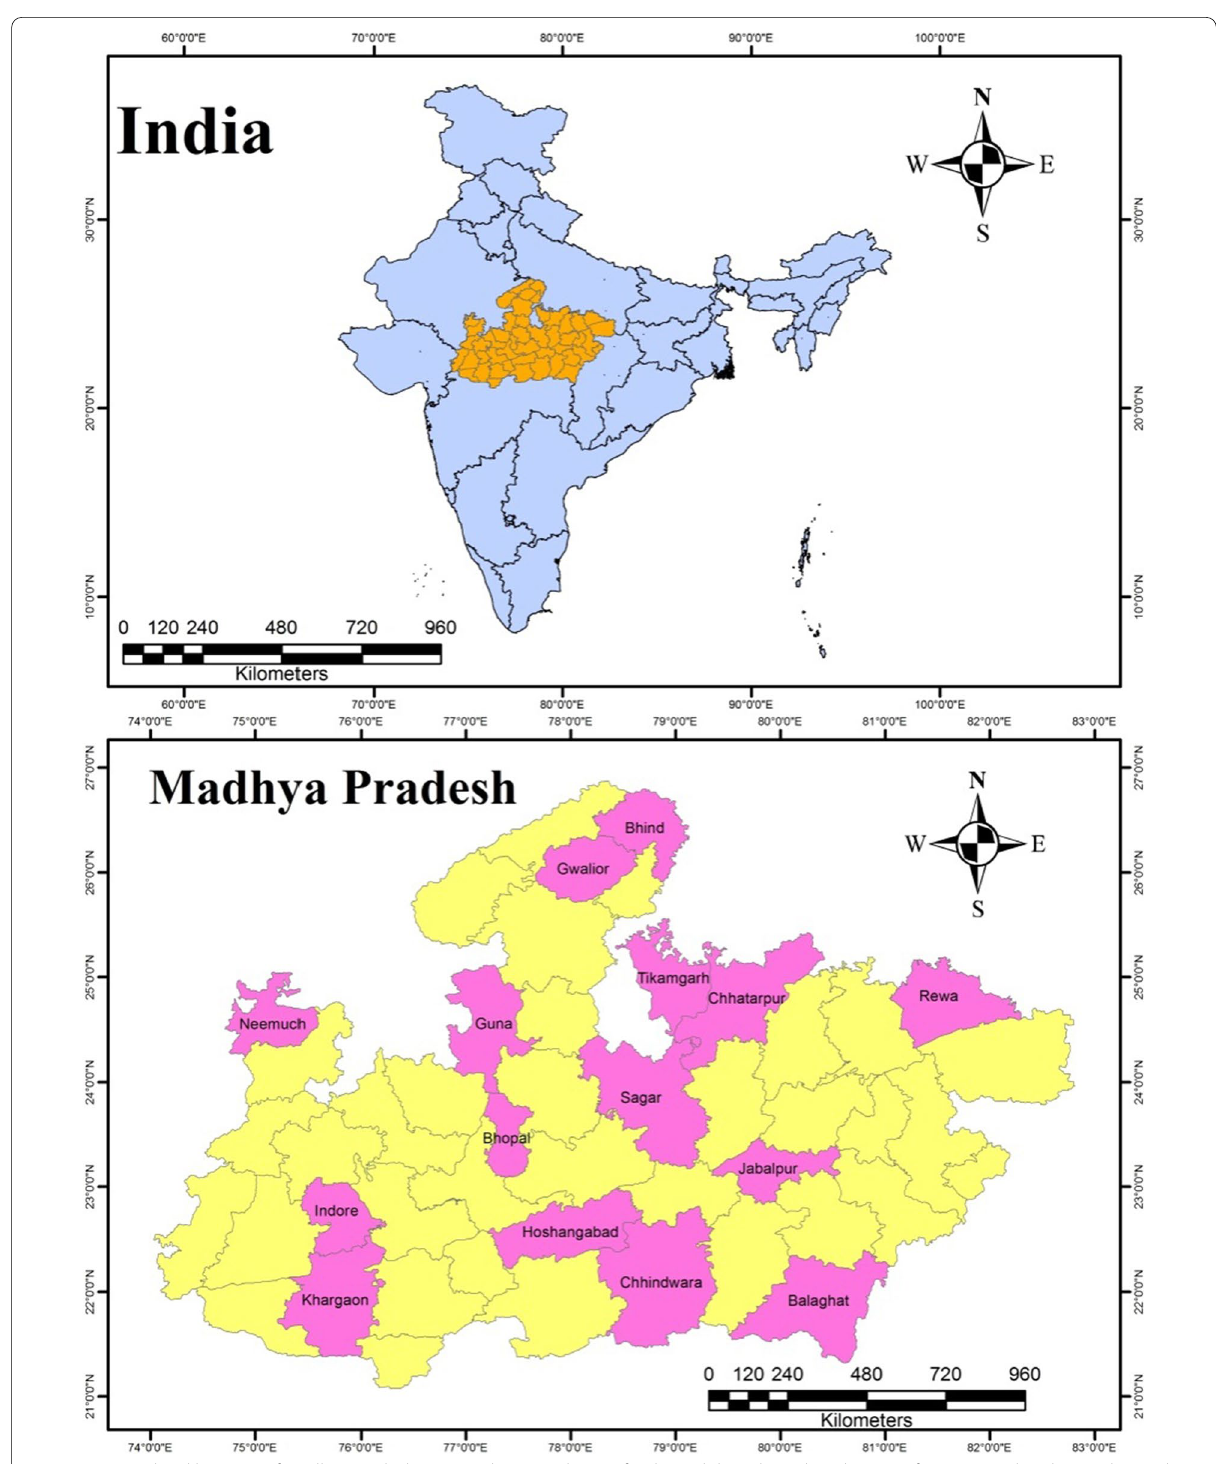
Fig. 1 Geographical location of Madhya Pradesh State in the central part of India and the selected 15 districts of interest undertaken in the study covering all the regions of